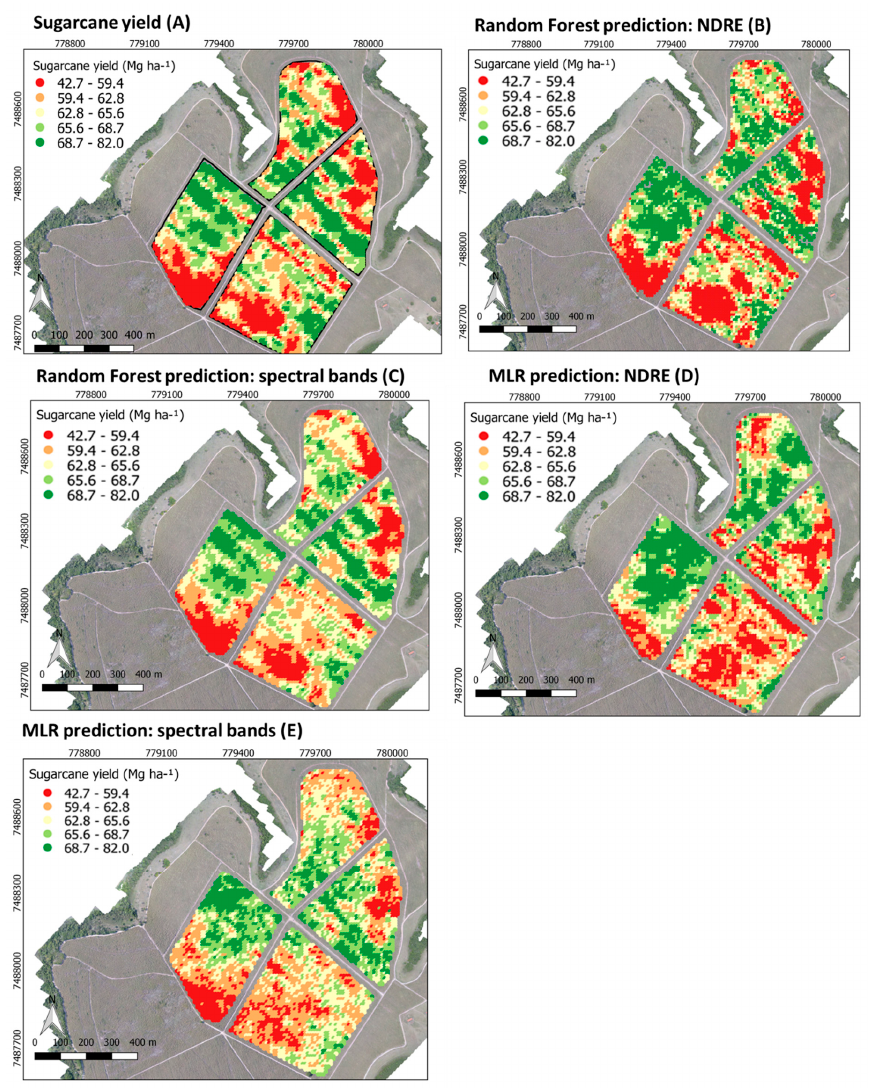
Figure 4. Observed sugarcane yield of 2018/2019 season ( A ). Predictive yield models based on Random Forest (RF) using: NDRE (Normalized Difference Red Edge) ( B ) and spectral bands ( C ). Predictive yield models based on Multiple Linear Regression (MLR) using: NDRE (Normalized Difference Red Edge) ( D ) and spectral bands ( E ).